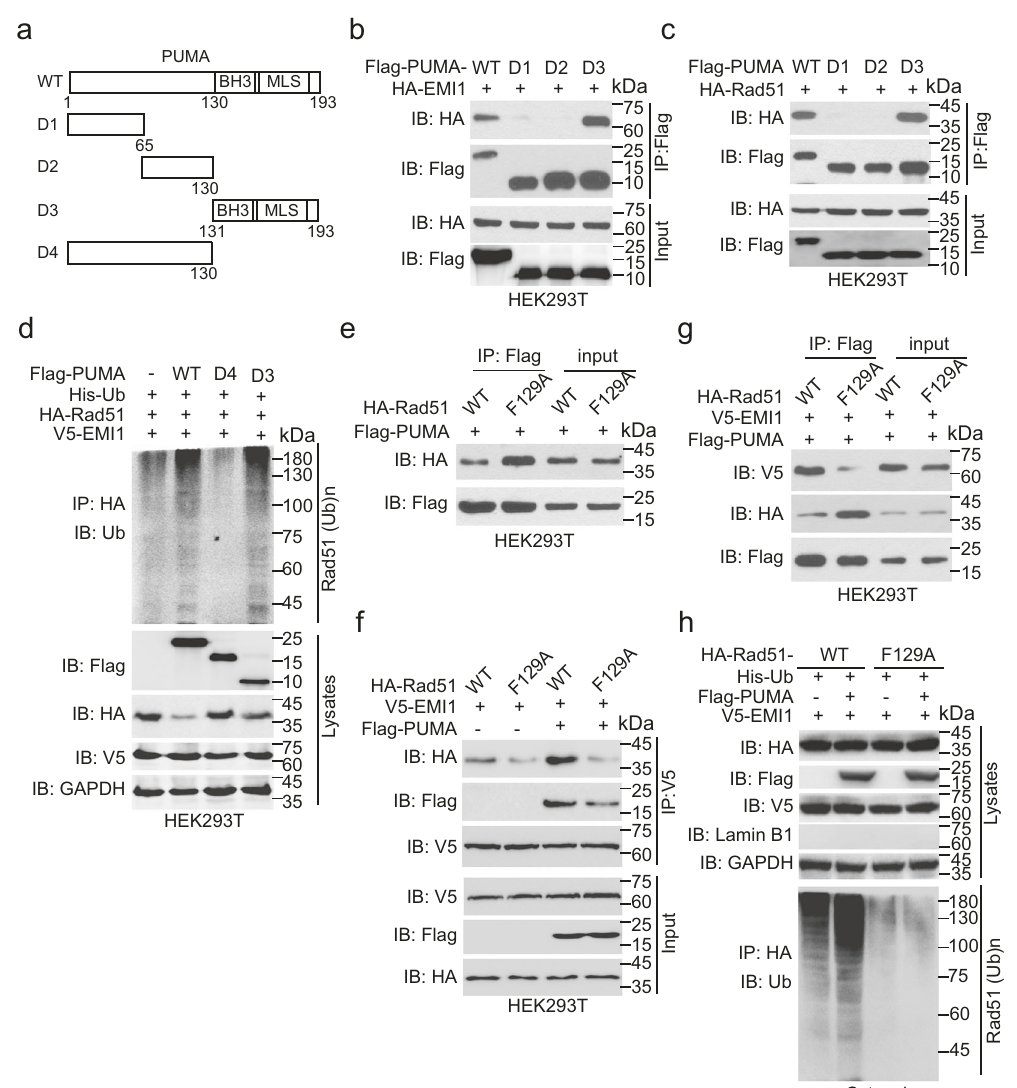
Fig. 5 PUMA promotes Rad51 ubiquitination by EMI1. a Schematics of PUMA WT and truncated constructs. b IP and IB of the interaction of PUMA mutants with EMI1 in HEK293T cells. Flag-tagged PUMA WTor the truncation mutants with HA-EMI1 was transfected into HEK293T cells. c IP and IB of the association of PUMA mutants with Rad51 in HEK293T cells. d Effects of ectopic expression of the D3 or D4 mutant of PUMA on EMI1-mediated Rad51 ubiquitination. Flag-tagged PUMA WT, the truncation mutants, or an empty vector with His-Ub, HA-Rad51, and V5- EMI1 was transfected into HEK293T cells. e IP and IB of PUMA interaction with Rad51 F129A mutant. f PUMA increases EMI1 association with Rad51 WT, but not the F129A mutant. V5-EMI1 and HA-Rad51 WT or F129A mutant with or without PUMA were co-expressed in HEK293T cells. g Effect of Rad51 F129A mutation on PUMA interaction with EMI1. h PUMA promotes EMI1-mediated the ubiquitination of cytosolic Rad51 WT, but not the F129A mutant. Data are representative of three independent experiments with similar results. Error bars, SD. * P < 0.05, ** P <